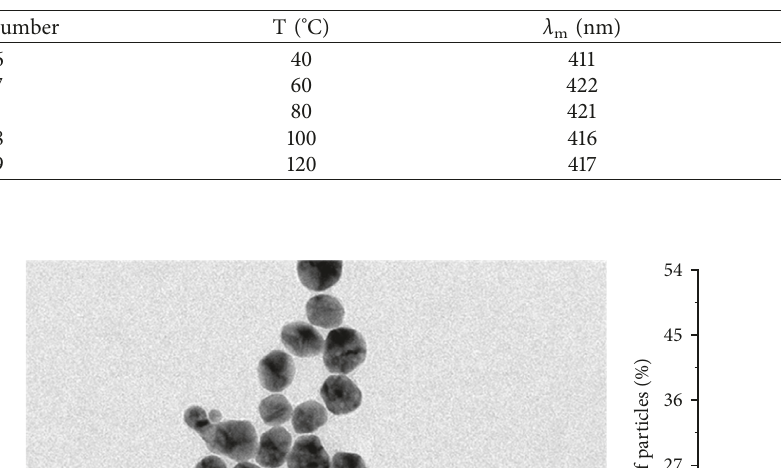
Table 5: Test results of AgNPs synthesized under different temperatures.